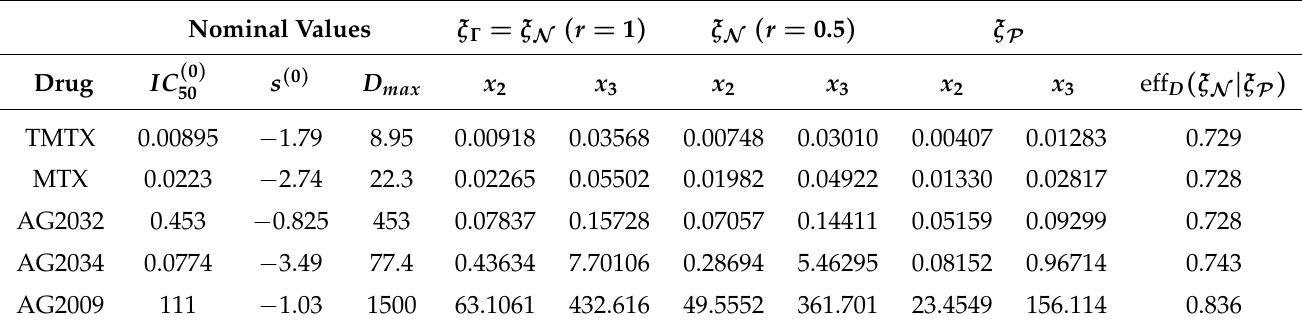
Table 4. Locally D-optimal designs { x 1 = 0, x 2 , x 3 , x 4 = D max } equally weighted for the 4-parameter Hill model for different ( 0 ) = 1.70 and b ( 0 ) = 0.137 were considered for all the drugs. drugs and probability distributions. The nominal values E con Columns 2–4 show the nominal values of the parameters and columns 5–10 show the internal points of the D-optimal designs ξ N , ξ Γ and ξ P . The last column shows the efficiency when comparing the design for the heteroscedastic normal distribution with r = 0.5 to the Poisson